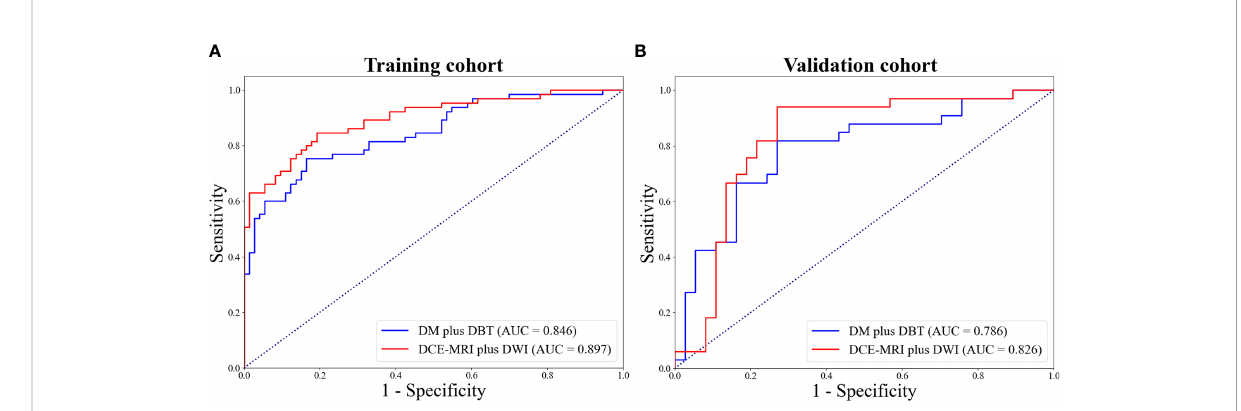
FIGURE 4 ROC curves for DW plus DBT and DCE-MRI plus DWI in the training (A) and validation (B) cohort.